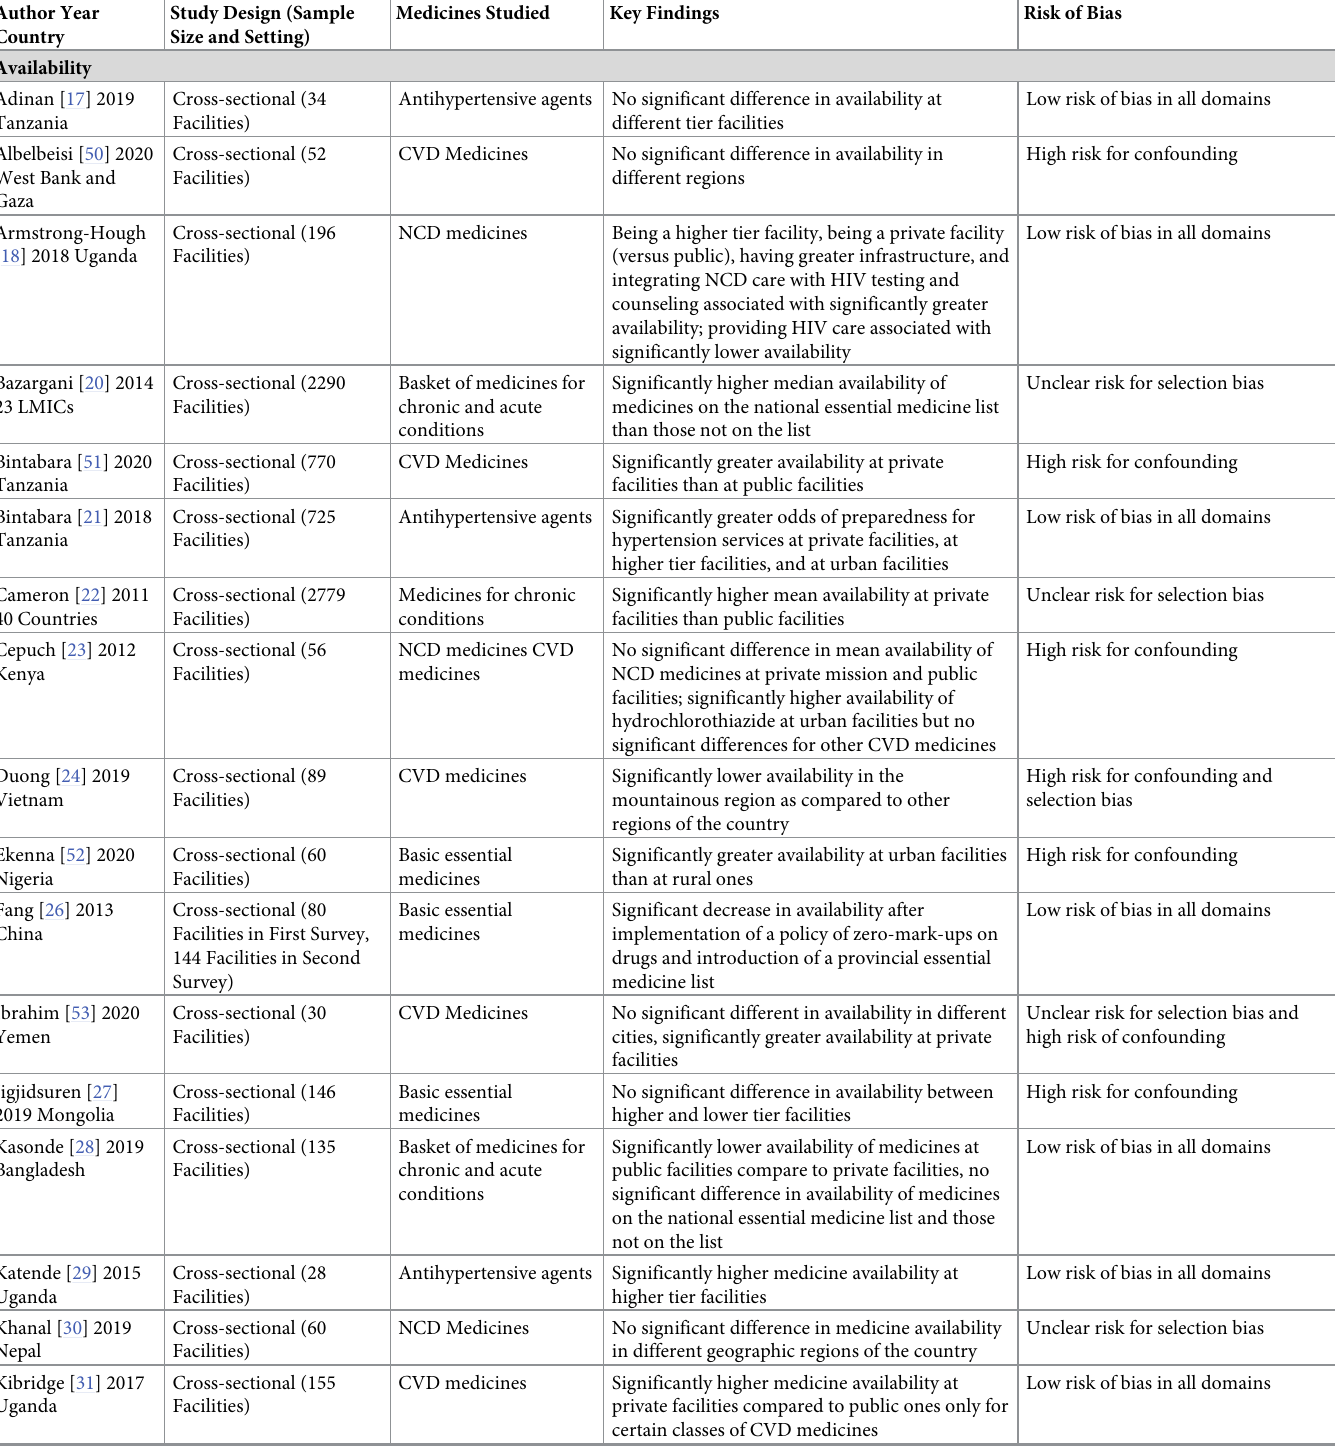
Table 2. Characteristics of identified